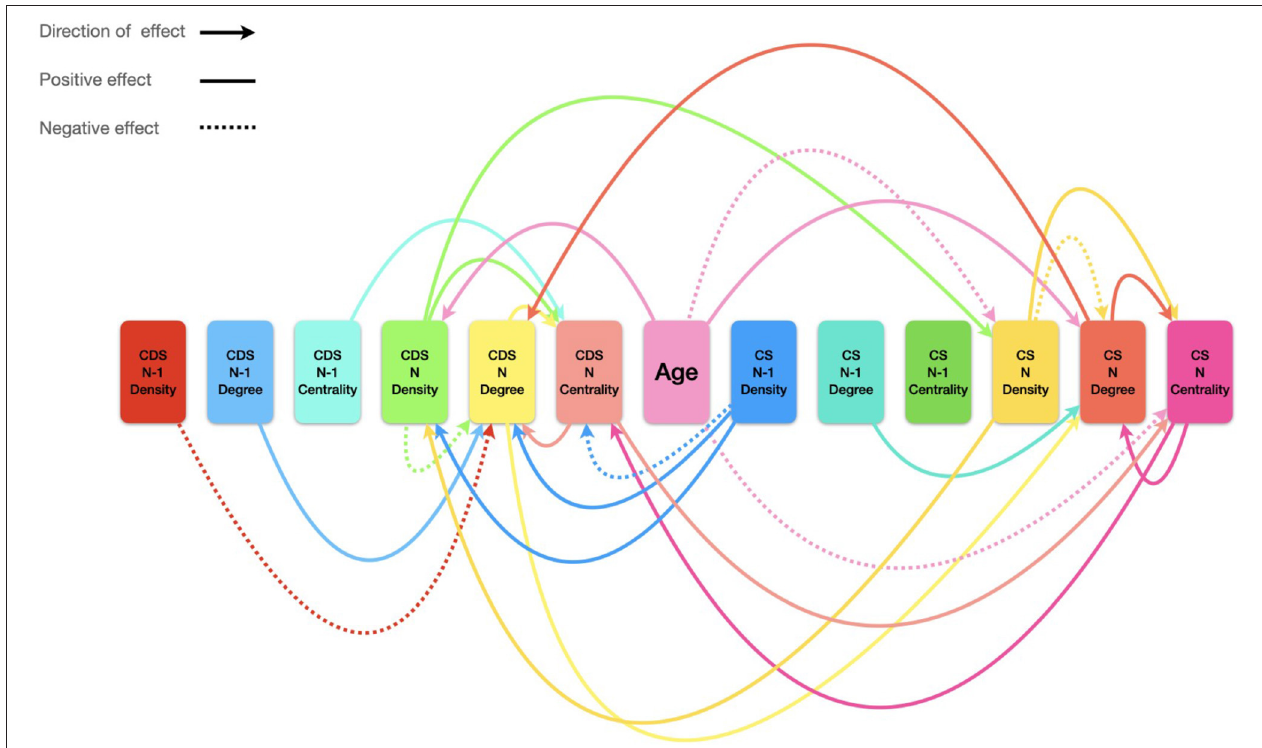
FIGURE 7 | A developmental model of a morphological verb lexicon network: The image shows a dynamic system of adaptation involving the child, the parent, and time. Arrows between affecting and affected network measures are colored according to the affecting variable; solid lines indicate positive effects, and dashed lines indicate negative